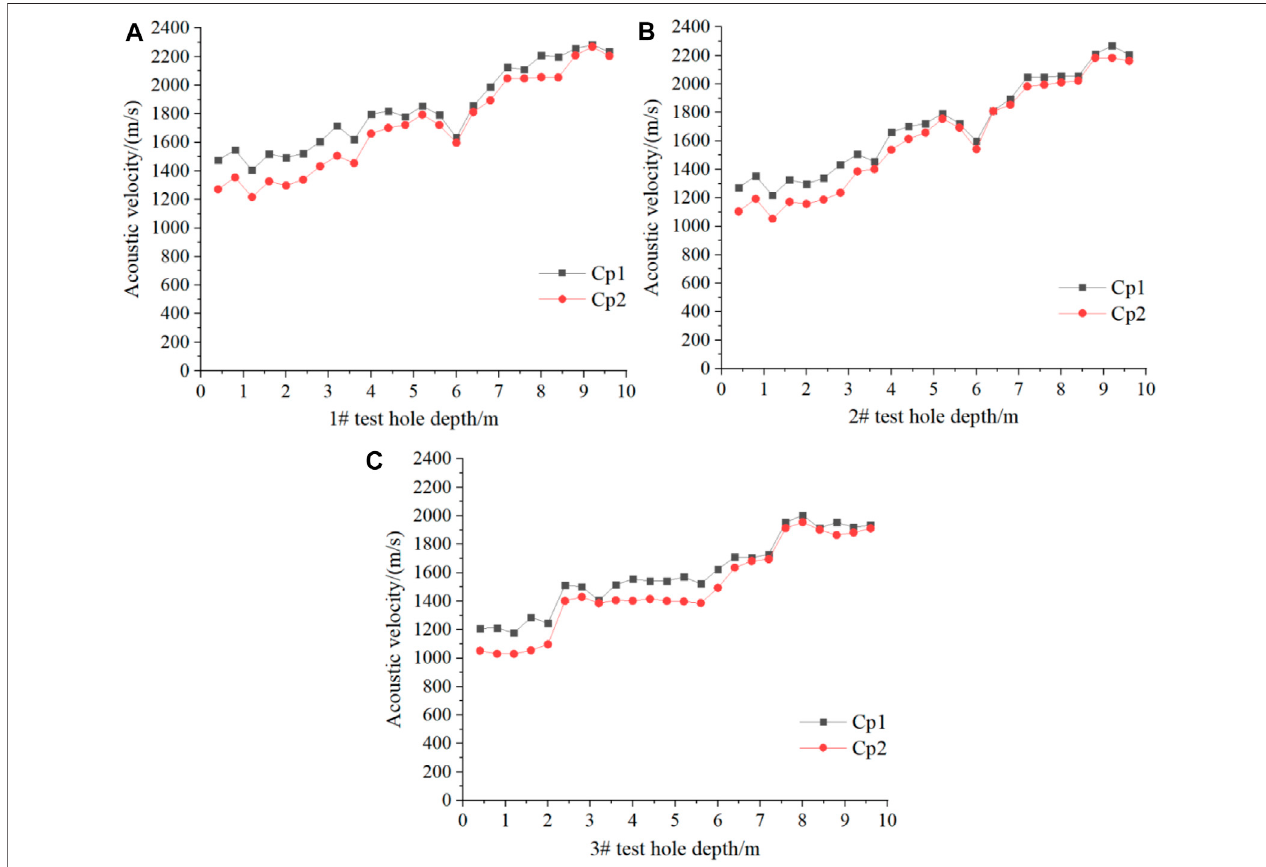
FIGURE12| Comparison ofsonic(longitudinalwave)wavespeedsbeforeandafter theexplosionofdifferenttest holes. (A) Comparison ofthesonicwavevelocity beforeandaftertheexplosionofthe1#testhole; (B) Comparisonofthesonicwavevelocitybeforeandaftertheexplosionofthe2#testhole; (C) Comparisonofthesonic wave velocity before and after the explosion of the 3# test